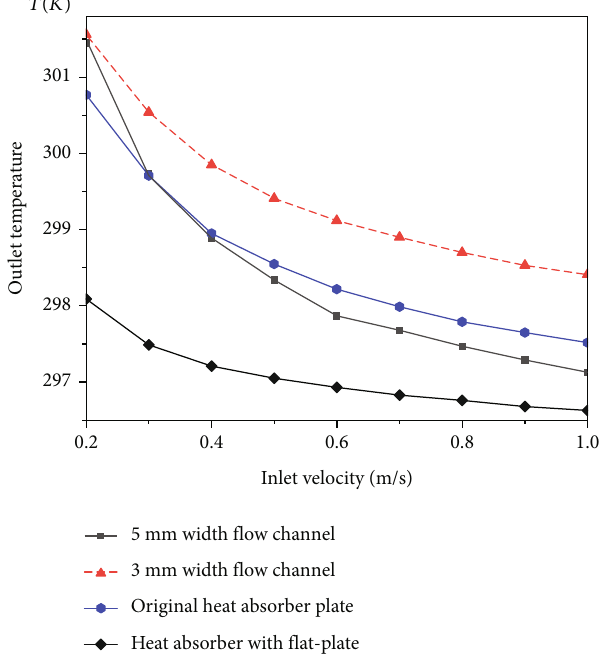
Figure 15: Outlet temperature comparison of three types of absorber plates after changing the fl ow channel